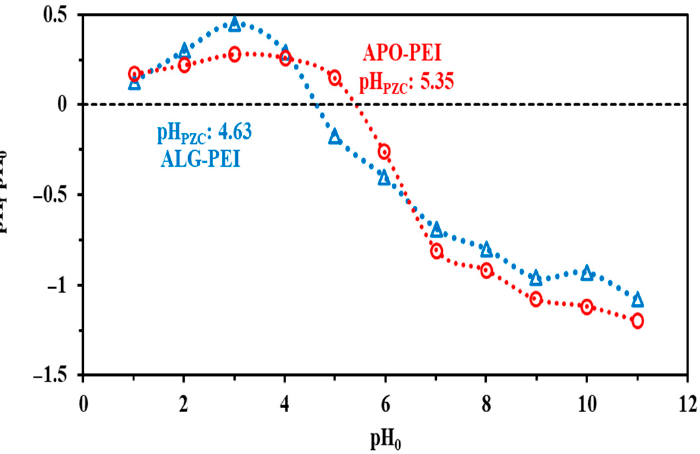
Figure A8. Determination of pH PZC values of ALG-PEI and APO-PEI sorbents (pH-drift method; background salt solution: 0.1 M NaCl; sorbent dose, SD: 2 g L − 1 ; time: 48 h; agitation, v: 210 rpm; T: 21 ± 1 °C). Table A1. Elemental analysis of ALG-PEI and APO-PEI sorbents.